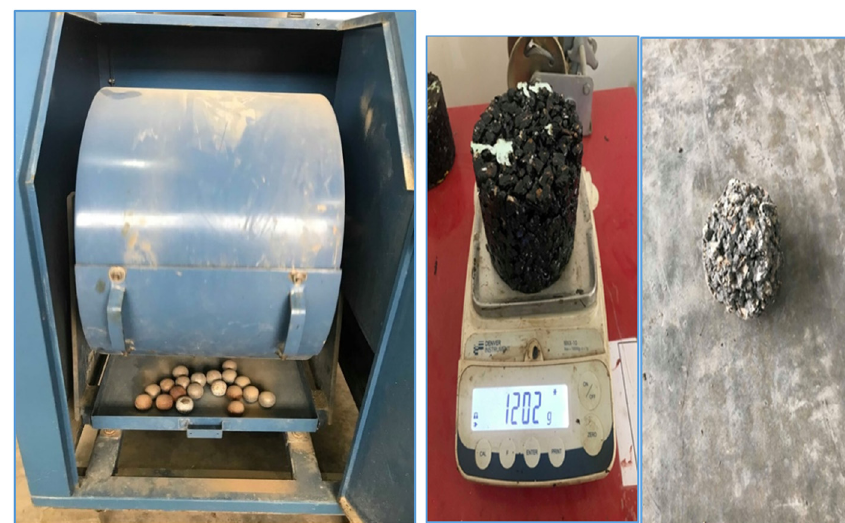
Figure 2: Los Angeles abrasion test.